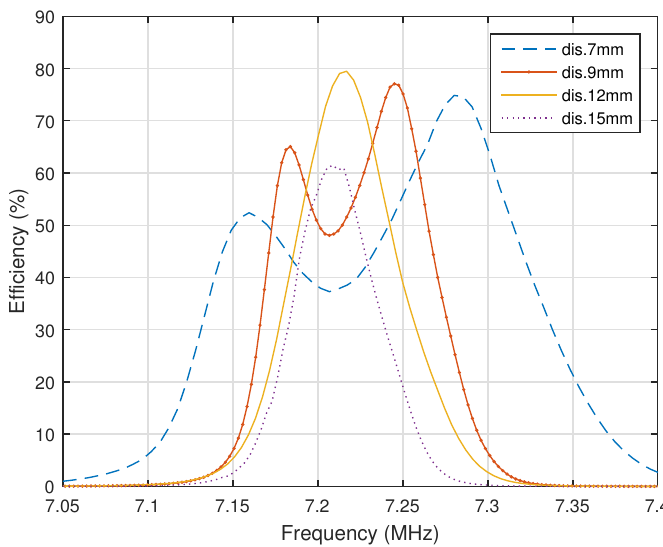
Figure 7. MATLAB converted results in transmission efficiency (%).